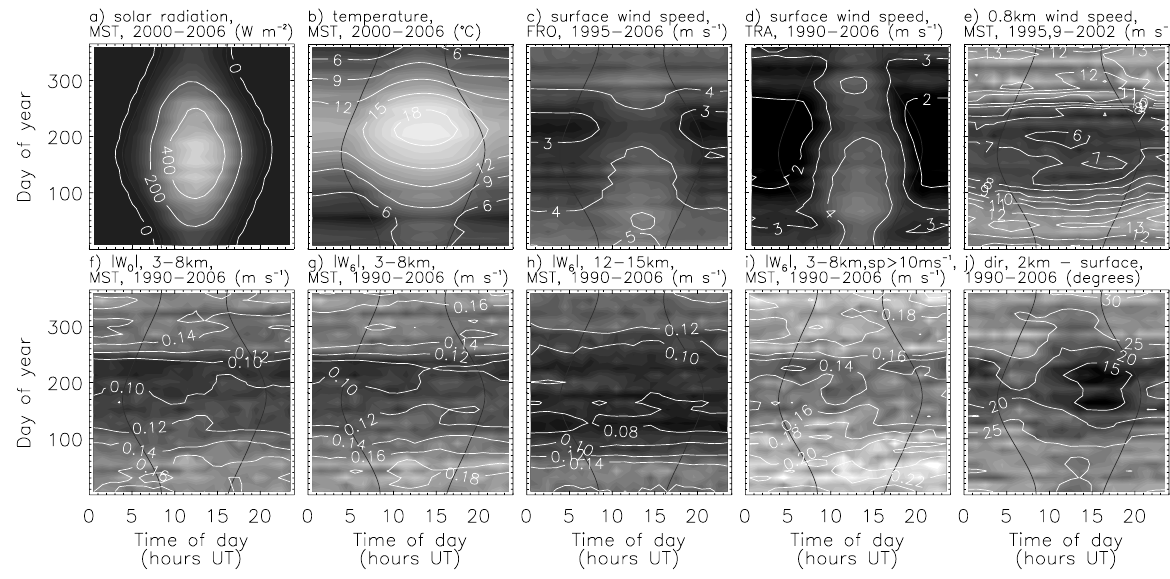
Fig. 8. Diurnal and seasonal variation of (a) solar radiation, (b) temperature, (c–e) wind speed, (f–i) | W | , (j) wind rotation across the boundary layer, measured at: Aberystwyth Meso-Strato-Troposphere radar site (MST), marked on Fig. 1; ∼ 3km west at Frongoch (FRO); and ∼ 9km south-south-east at Trawscoed (TRA). (e) uses UHF radar; (j) uses VHF radar and average of surface wind sites in Fig. 1. Curved black lines show times of sunrise and sunset.